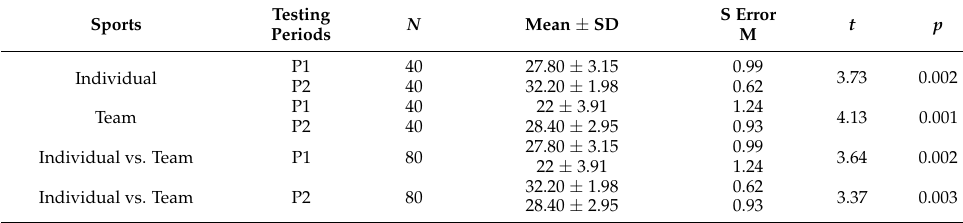
Table 1. Results obtained for Rosenberg Self-Esteem Scale.